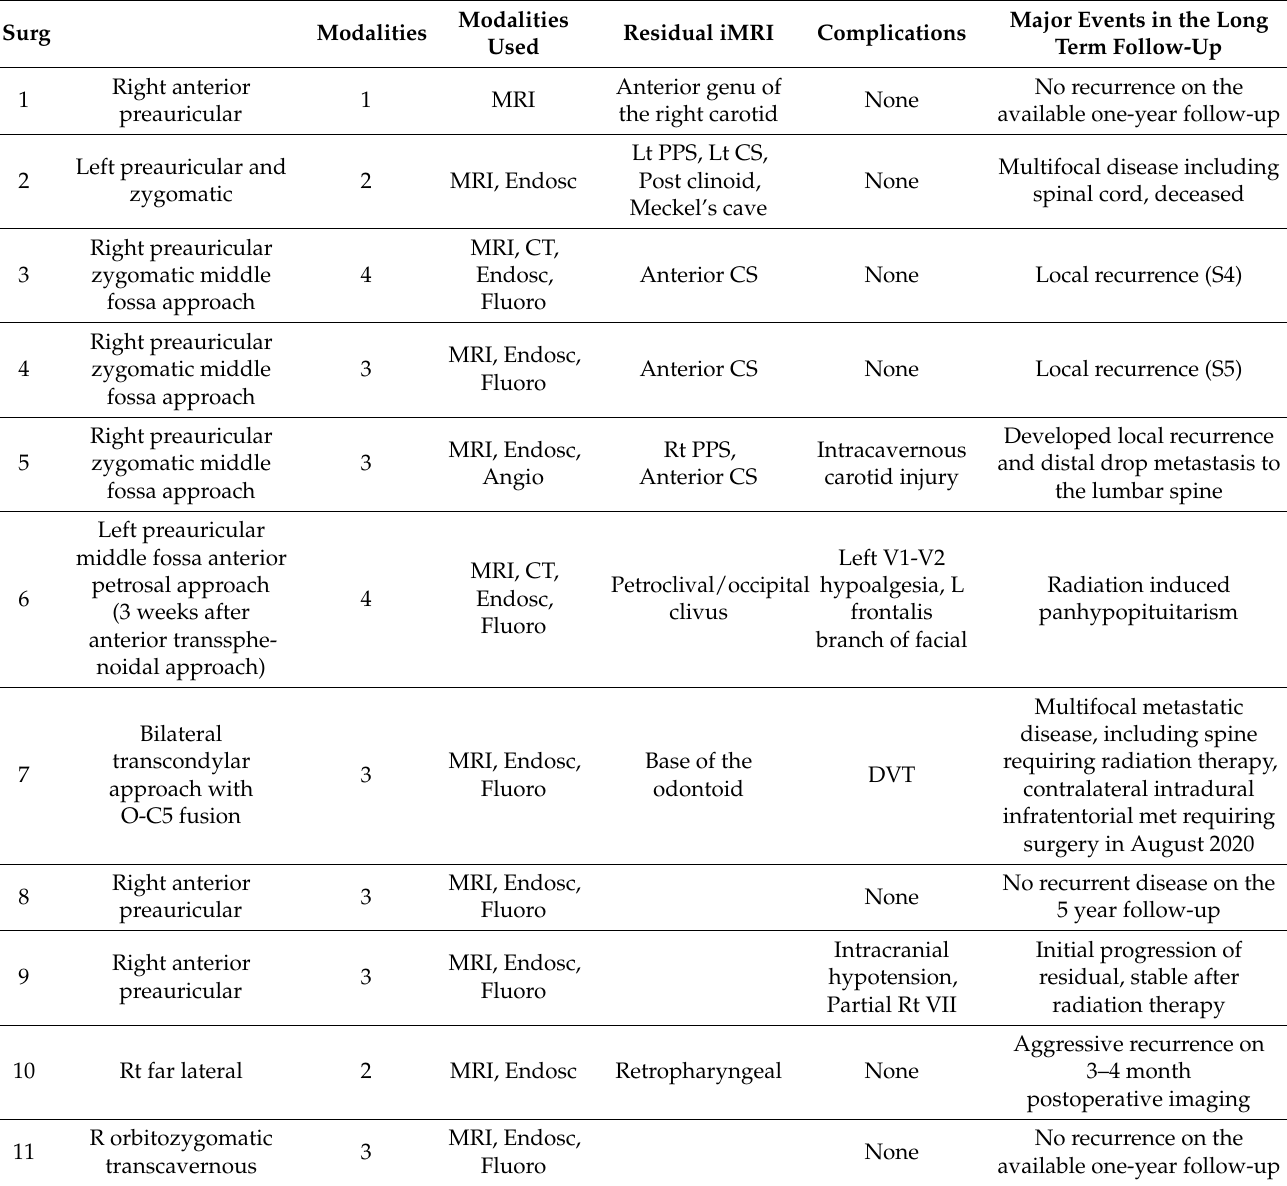
Table 3. Surgeries and